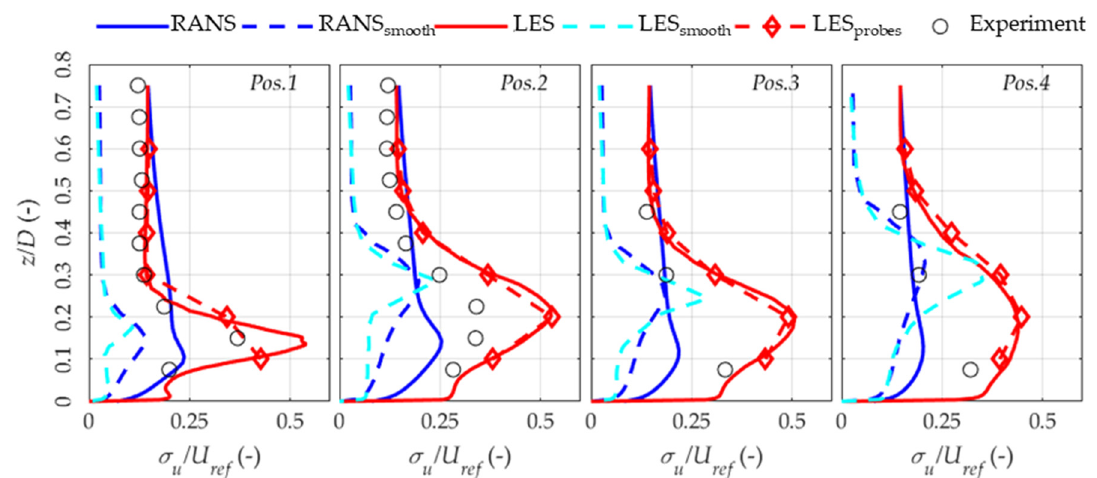
Figure 9. Longitudinal turbulence intensity for positions 1–4. The continuous line refers to the turbulent inlet, and the dashed line to the smooth inlet. LES results were computed using both ensemble averages and time averages from probes for comparison.